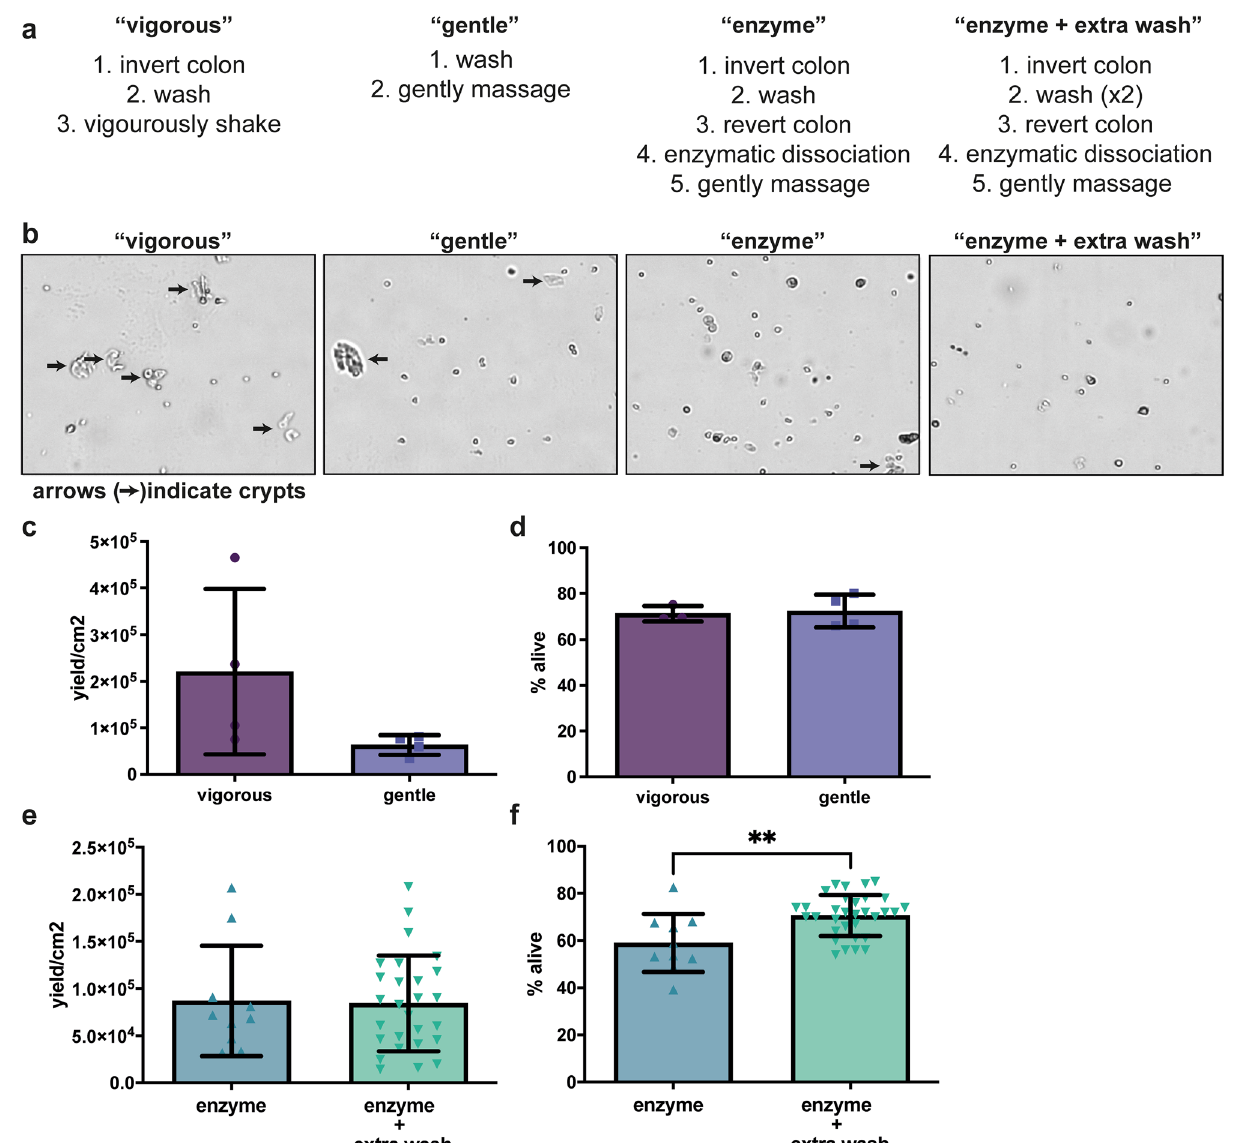
Representative brightfield images of the isolated cell populations for the different isolation methods; crypts are indicated with arrows. ( c , d ) Analysis of yield and viability of the vigorous and gentle isolation methods (n = 4 pigs per isolation method). ( e,f ) Analysis of yield and viability of enzymatic (enzyme) and enzymatic with additional washing step (enzyme + extra wash) dissociation methods (n = 8 pigs for enzyme procedure, n = 27 pigs for enzyme + extra wash). Student’s t-tests were performed to compare yield and viability of the enzyme and enzyme + wash methods, **indicates a p -value of ≤ 0.01. Each dot in the bar-graphs represents an IEC isolation from a single